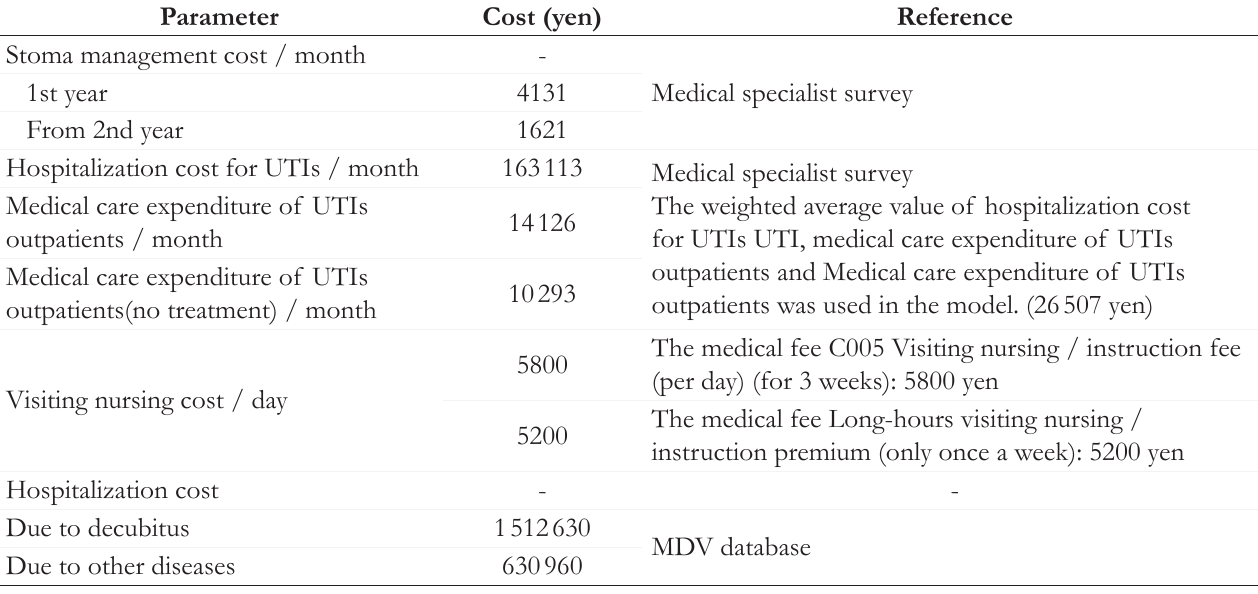
Table 4. Cost Parameters - continued